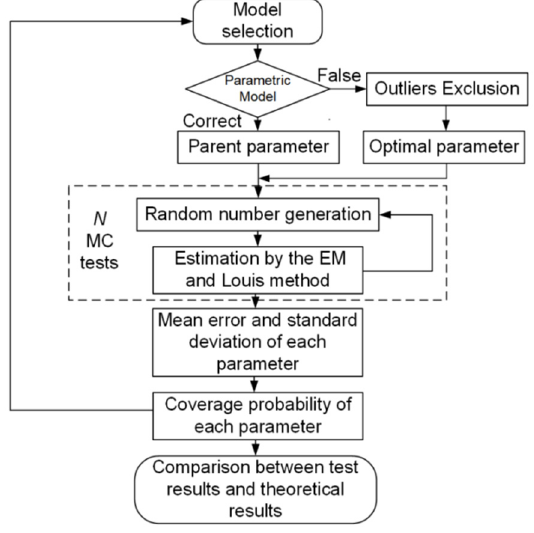
Figure 3. Flowchart of the MC simulation process for verifying the error types. Table 3. Correct parametric model results.